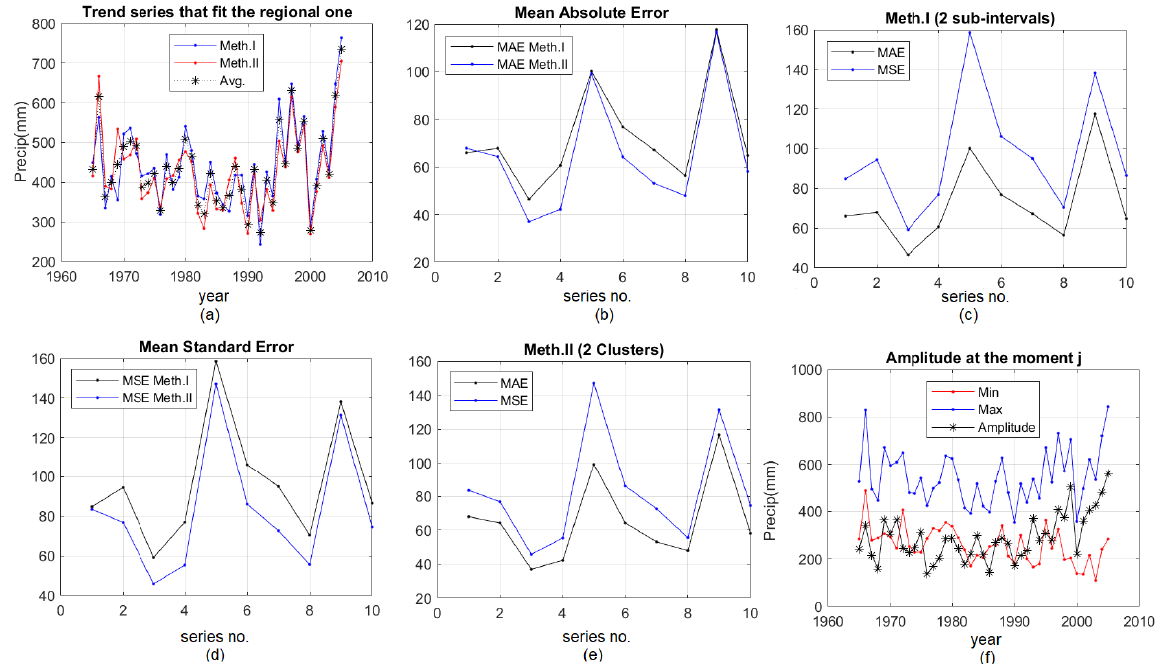
Figure 9. Study results when using two intervals/clusters ( a ) “Trend series that fit the regional one”; ( b ) MAE in both methods; ( c ) MAE and MSE in Method I; ( d ) MSEs from both methods; ( e ) MAE and MSE from Method II; ( f ) Minimum, Maximum and Amplitude Series amplitude.